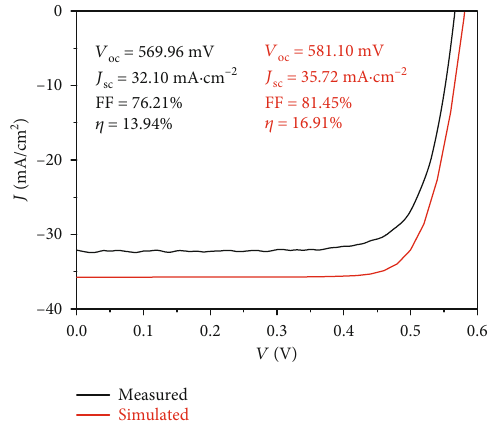
Figure 2: Current density versus voltage ( J – V ) curves of the measured MSHJ solar cell and the simulated model.